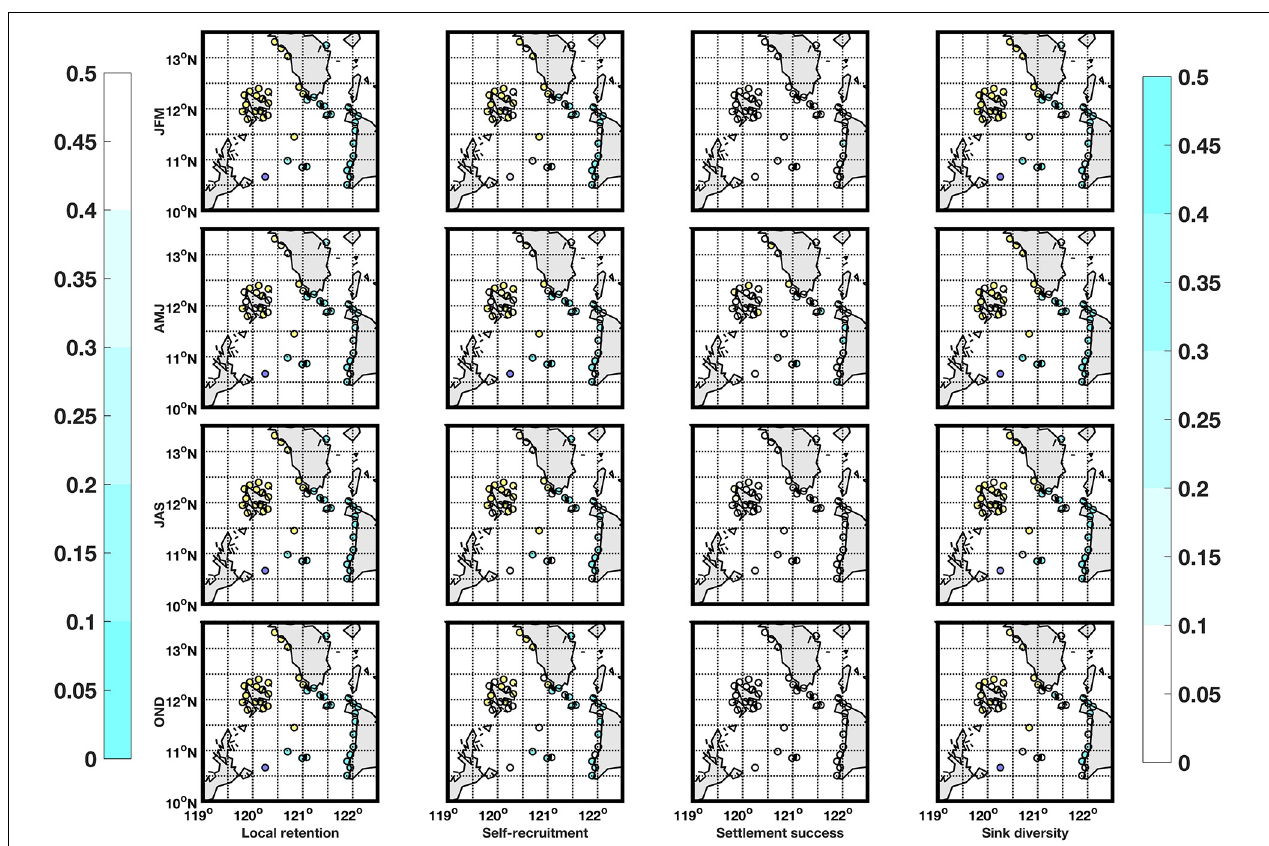
FIGURE 6 | Local retention (column 1) , self-recruitment (column 2) , settlement success (column 3) , and sink diversity (column 4) values for locations with suitable habitat for H. scabra species for the NEM (row 1) , dry-transition (row 2) , SWM (row 3) , and early NEM (row 4) . Locations are colored according to their marine province (Group 1 = purple, Group 2 = cyan, and Group 3 = yellow). Local retention and self-recruitment (settlement success and source diversity) values are shaded according to the representative colorbar on the left (right) and as such, possible priority locations are in darker shades for all maps.